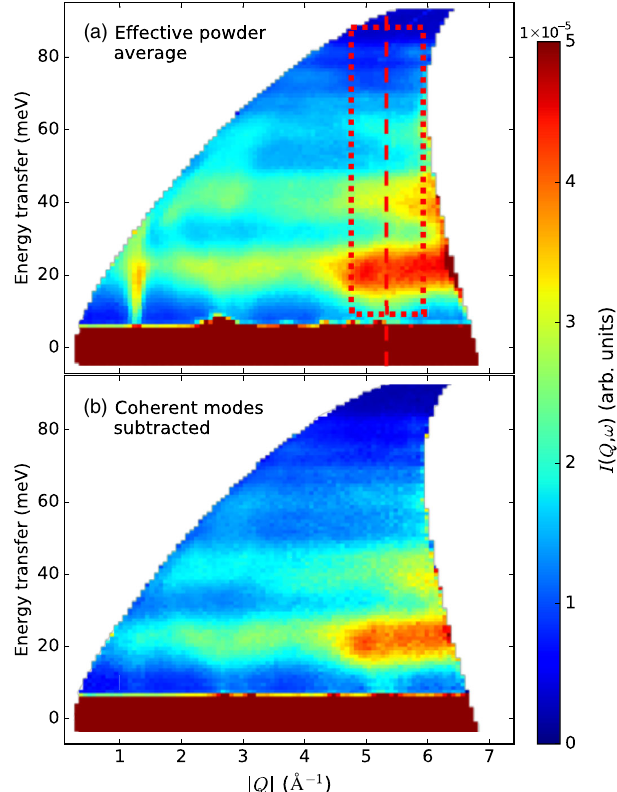
FIG. 7. (a) An effective powder average (taken over all collected sample rotation angles) for the single-crystal ð V Þ ¼ 5 K data. The dashed red lines indicate 0 . 96 Cr 0 . 04 2 O 3 T the range of wave vector transfer used to generate the phonon DOS shown in Fig. 8. (b) Powder average of the same data excluding scattering that depends on the azimuthal angle ϕ . Such filtered data were utilized as